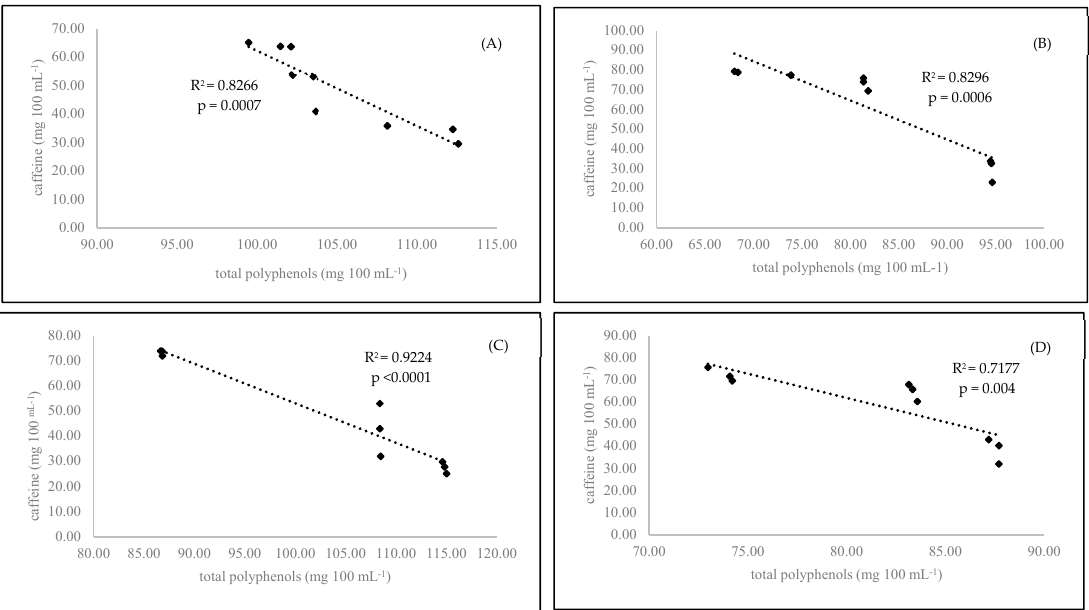
Figure 1. Linear regression (Pearson’s coefficient R 2 ) between caffeine and total polyphenols in organic 3-minutes-brewing coffee ( A ), conventional 3-minutes-brewing coffee ( B ), conventional 6-minutes-brewing coffee ( C ), and conventional 6-minutes-brewing coffee ( D ).